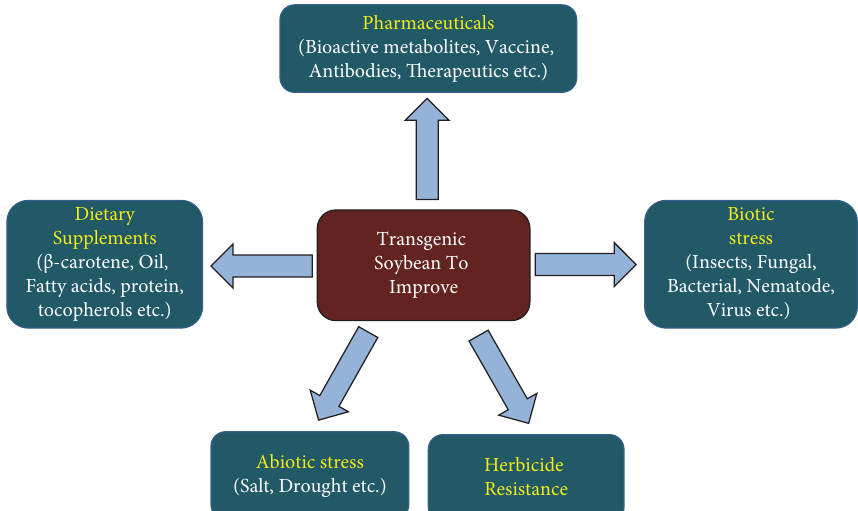
Figure 1: Transgenic approach used for the enhancement of potential traits of soybean